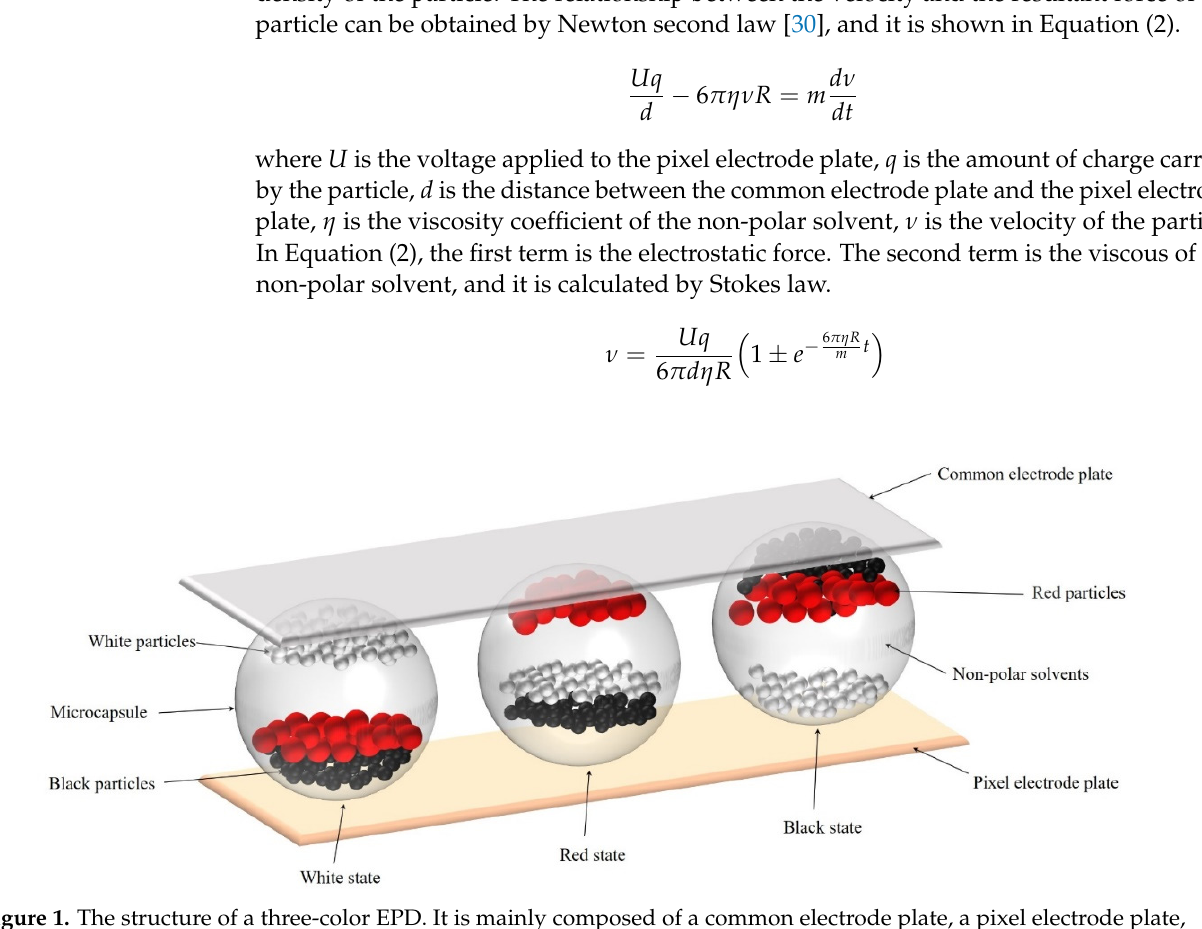
Figure 1. The structure of a three-color EPD. It is mainly composed of a common electrode plate, a pixel electrode plate, black particles, white particles, red particles, and non-polar solvents. The white state is the situation when white particles are driven to the common electrode plate. The red state is the situation when red particles are driven to the common electrode plate. The black state is the situation when black particles are driven to the common electrode plate.